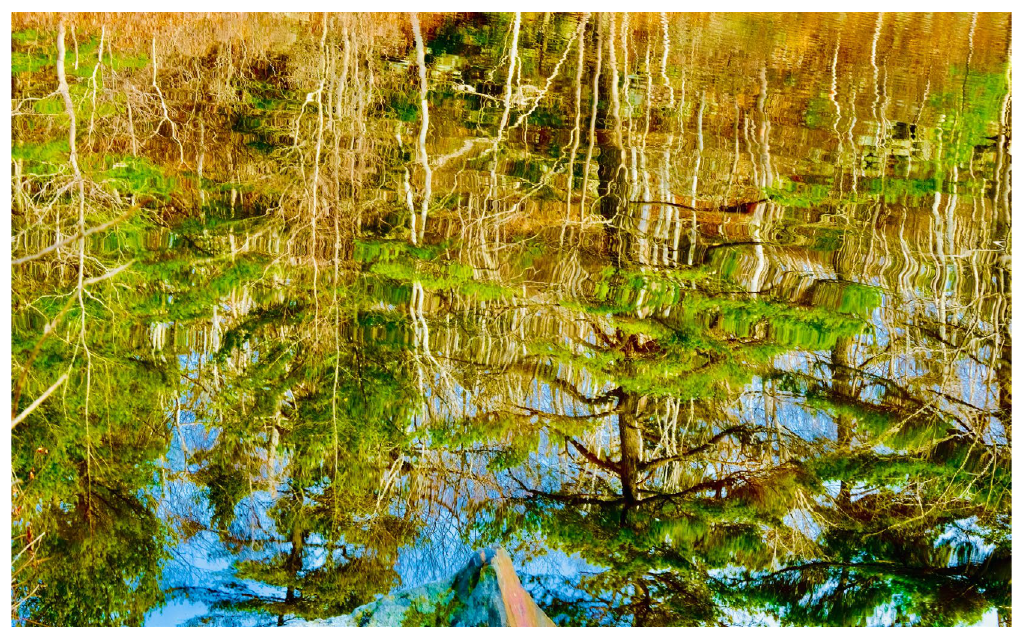
Figure 9. Healing Reflected Back to the Earth and